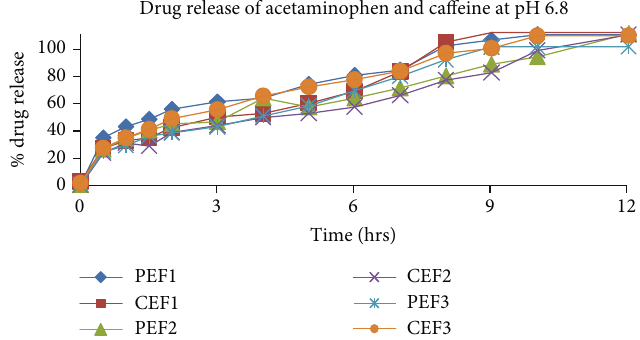
Figure 3: Drug release pro fi le of acetaminophen and ca ff eine at pH